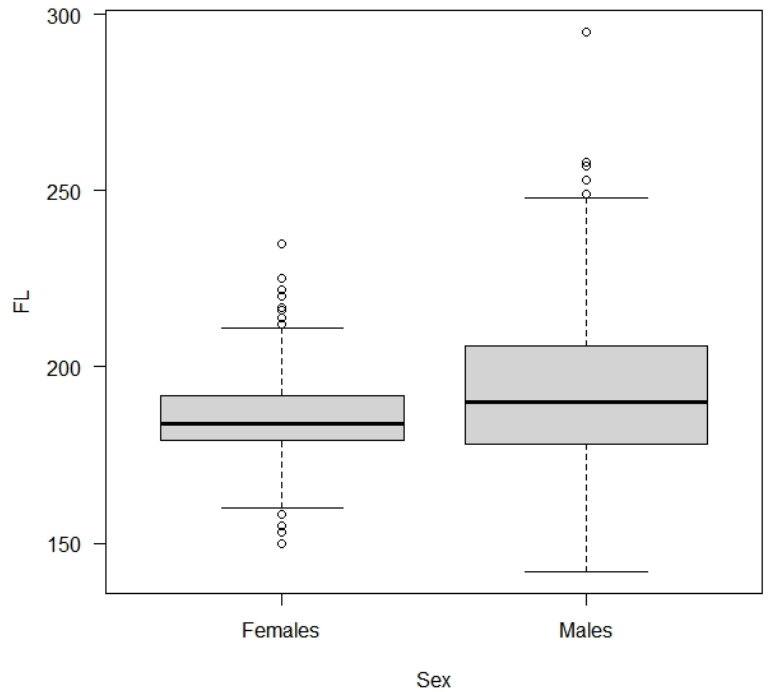
Figure 8. Observed fork length by sex in the Pacific Ocean.